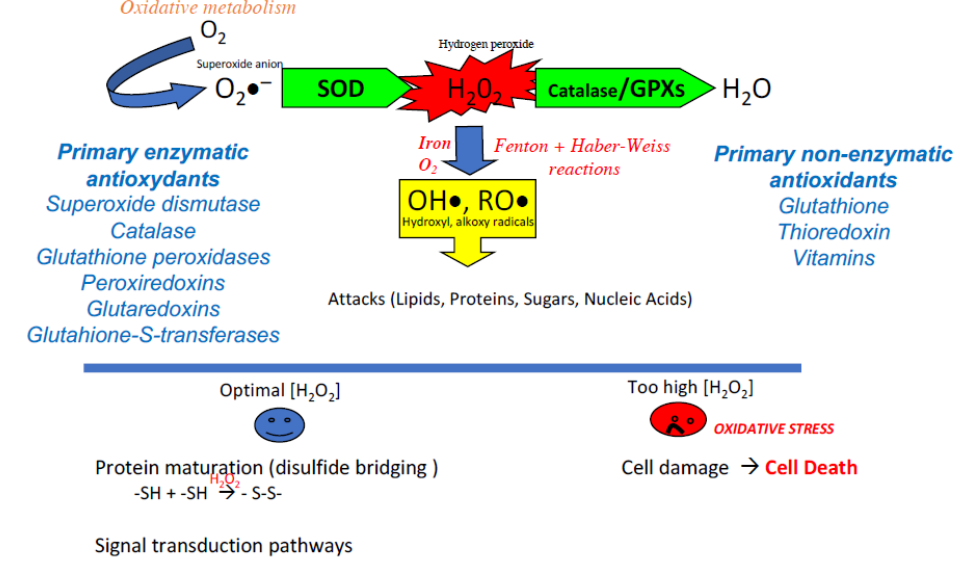
Figure 1. The classic reaction cascade for the production of reactive oxygen species of metazoans. The consumption of oxygen, which supports the production of energy by the mitochondrial respiratory chain, results in the production of the anion radical superoxide (O 2 · − ). Although weakly reactive and not permeant the superoxide anion is readily transformed (via the action of superoxide dismutase: SOD) into an active oxygen derivative, hydrogen peroxide (H 2 O 2 ). This molecule occupies a crossroad position having important actions in the maturation of proteins via the oxidation of thiol groups as well as serving as a stimulus and second messenger in critical signal transduction pathways. However, if an excess of H 2 O 2 is produced, its strong penetration into the cellular compartments and its rapid reactivity with iron and oxygen (via the Fenton and Haber-Weiss reactions) lead to the production of very aggressive free radicals (hydroxyl and alkoxy radicals) for which there is no active recycling system. These free radicals attack all organic components (lipids, proteins, sugars, and up to nucleic acids). The multiple alterations generated if they are not su ffi ciently corrected can lead to cellular dysfunctions and eventually to cell death. To finely regulate the concentration of H 2 O 2 , both in the extracellular and intracellular compartments, metazoans have developed several enzymatic activities grouped under the classification of primary enzymatic antioxidants (GPxs: glutathione peroxidases, CAT: catalase, PRxs: peroxiredoxins, GRx: glutaredoxins, GSTs: glutathione S-transferases) to transform H 2 O 2 into a neutral element, water (H 2 O). In the same way, several non-enzymatic molecules (glutathione, thioredoxin, vitamins) are at work to trap free radicals.